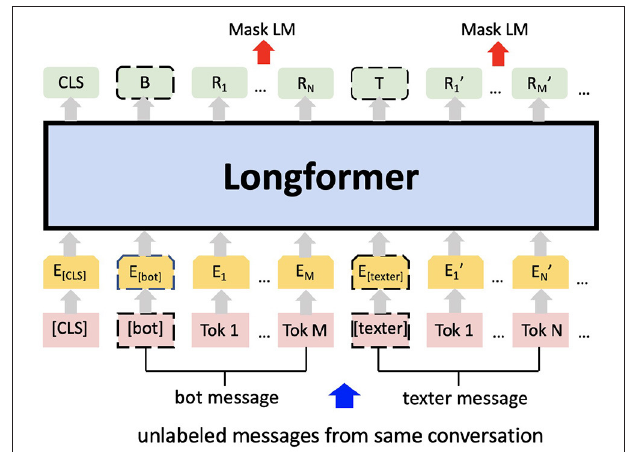
FIGURE 2 | Additional pre-training on the masked language modelling (MLM) task using Shout mental health data. E represents the input embeddings. R i represents the contextual representation of token i . B and T are the contextual representations of special token [bot] and [texter] respectively. After the tokenisation the numerical vectors are processed via